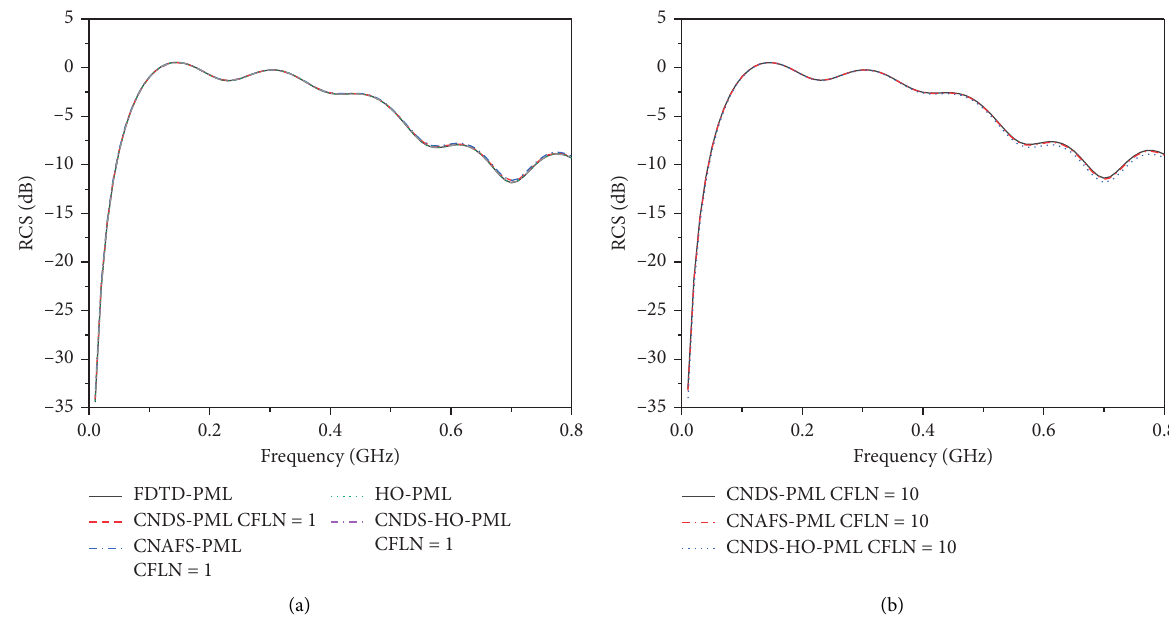
Figure 3: The RCS of the flight vehicle model versus frequency obtained by (a) FDTD-PML, CNDS-PML, CNAFS-PML, HO-PML, and